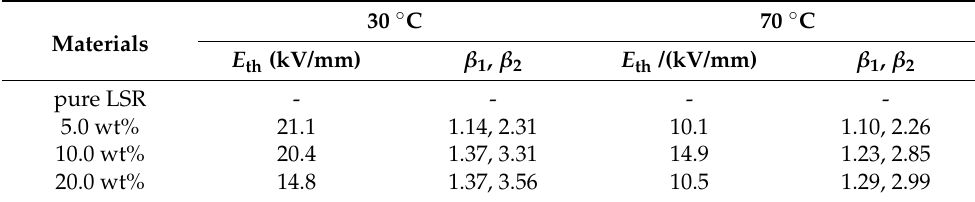
Figure 5. Electric conductance characteristics in the logarithm J - E curves of pure LSR and SiC/LSR nanocomposites at diverse temperatures of: ( a ) 30 ◦ C; and ( b ) 70 ◦ C; hopping conductance character- istics of fitting conductivities for the SiC/LSR nanocomposites at ( c ) 30 ◦ C; and ( d ) 70 ◦ C. Table 2. Nonlinear coefficients of the SiC/LSR